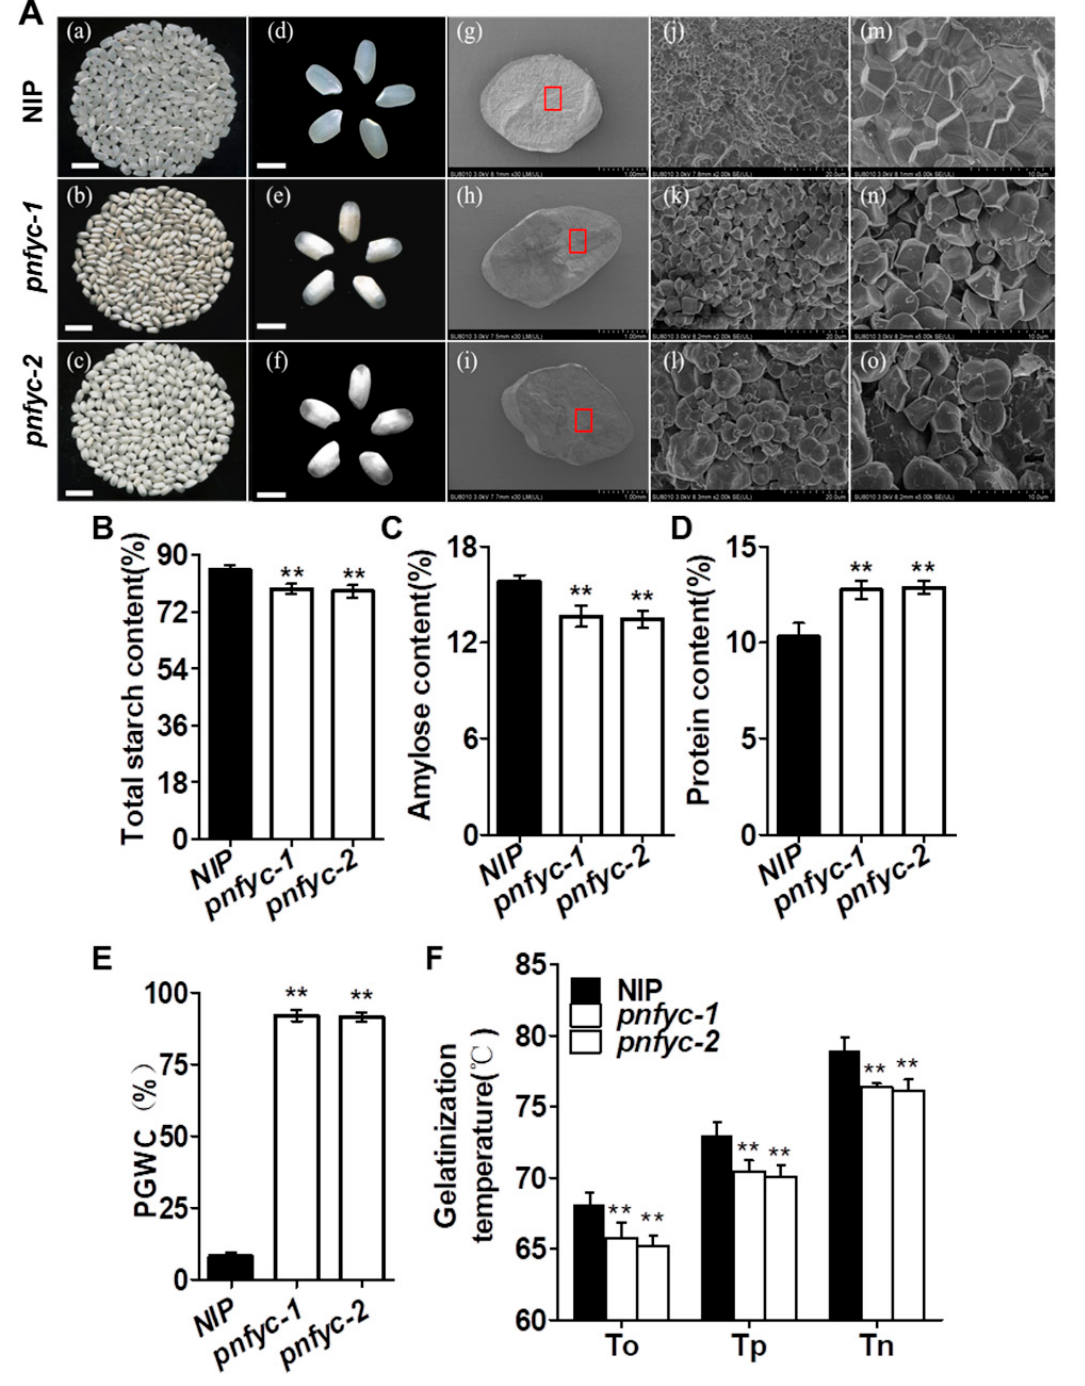
Figure 1. ( A ) (a–o) Grain chalkiness phenotypical characterization (a–f), bar = 2 mm. Scanning electron microscopy (SEM) analysis (g–o). The central areas shown are indicated as red squares. The magnification is 30 times in (g,h,i); 2000 times in (j,k,l), and 5000 times in (m,n,o). ( B – F ) Quality trait parameters of mature seeds from pnfyc lines and NIP. Data are shown as means ± SD of at least